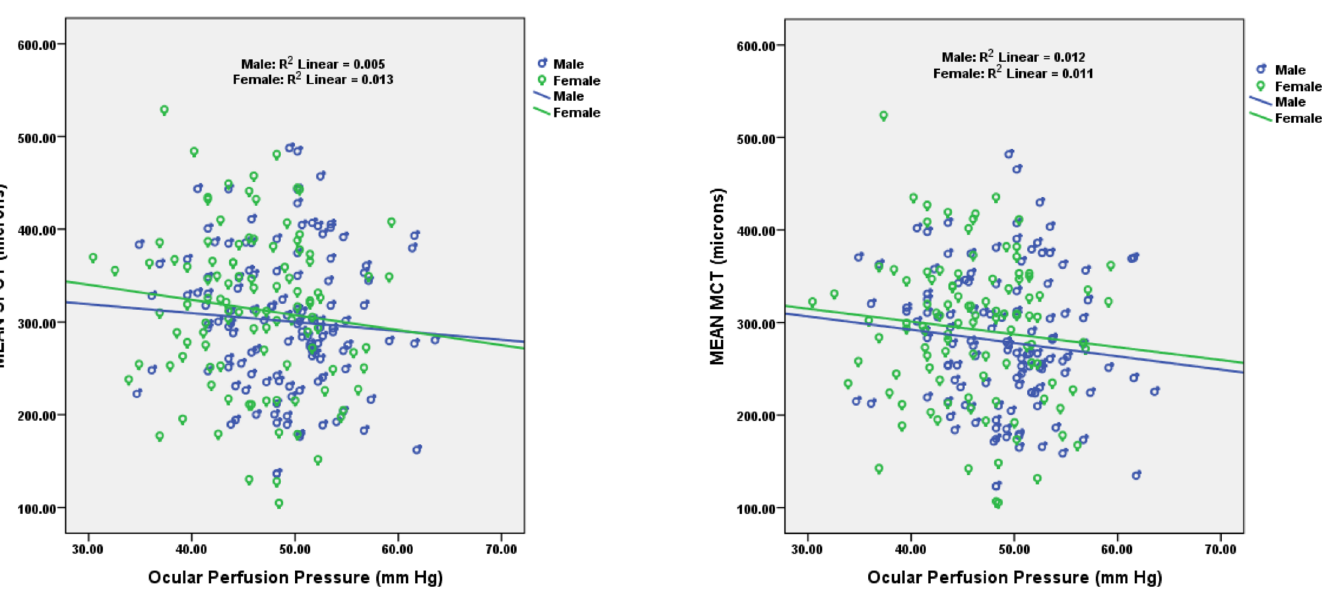
PLOS ONE | https://doi.org/10.1371/journal.pone.0197457 May 16,